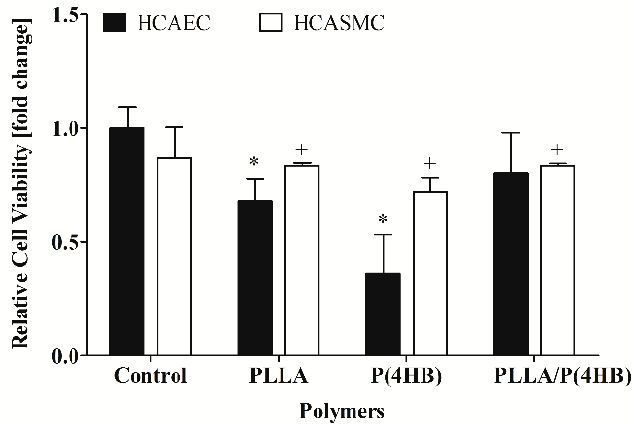
Figure 1. The viability of vascular cells is influenced by polymers. Human coronary artery endothelial cells (HCAEC) and human coronary artery smooth muscle cells (HCASMC) were cultured on control and polymer surfaces for six days. Cell viability was determined after incubation with AlamarBlue ® (Biosource, Camarillo, CA, USA). Bars show mean ± SD of six separate experiments normalized to the control with * p < 0.05 compared to the HCAEC control and + p < 0.05 compared to the HCASMC control.